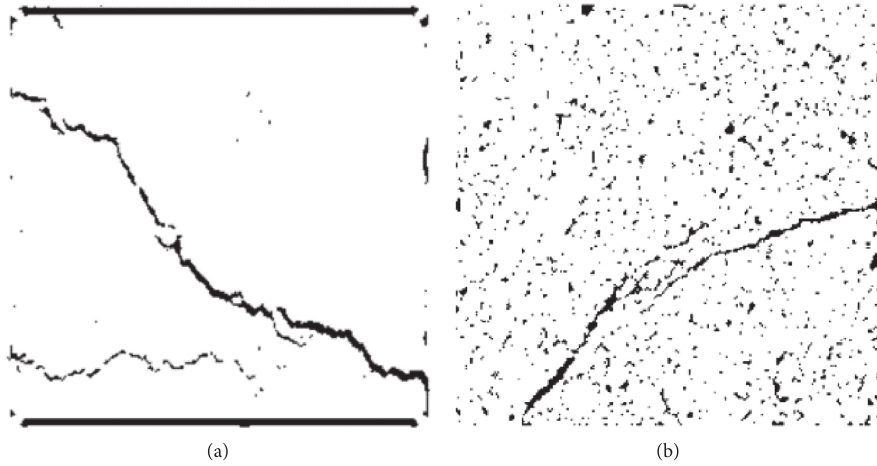
Figure 23: Percolation results using the same-padding technique: (a) crack 1; (b) crack 2.